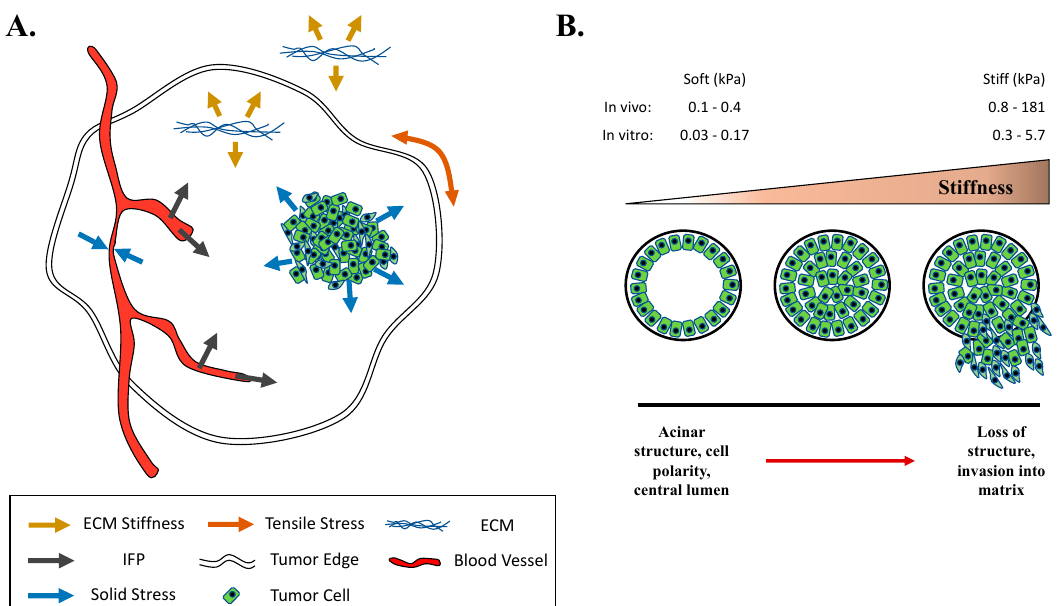
Figure 3. Mechanical signals in the tumor microenvironment. A: Pathologic mechanical signals present in the tumor microenvironment include stiffness, interstitial fluid pressure (IFP), solid stress, and tensile circumferential stress. B: Stiffness, a clinical risk factor for breast cancer, increases during tumor progression in vivo. In vitro studies show that stiffness can push normal mammary epithelial cells toward a malignant phenotype. As stiffness increases, the normal acinar structures formed by MCF10A cells become disrupted and cells become invasive into the extracellular matrix.